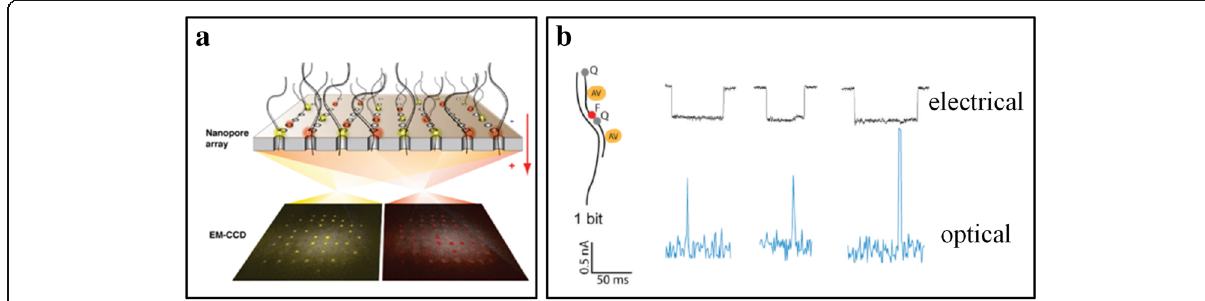
Fig. 5 Total internal reflection fluorescence (FTIR) parallel detection of DNA sequence [58]. a Schematic diagram. b Signal map of optical and ion current signals detected in the